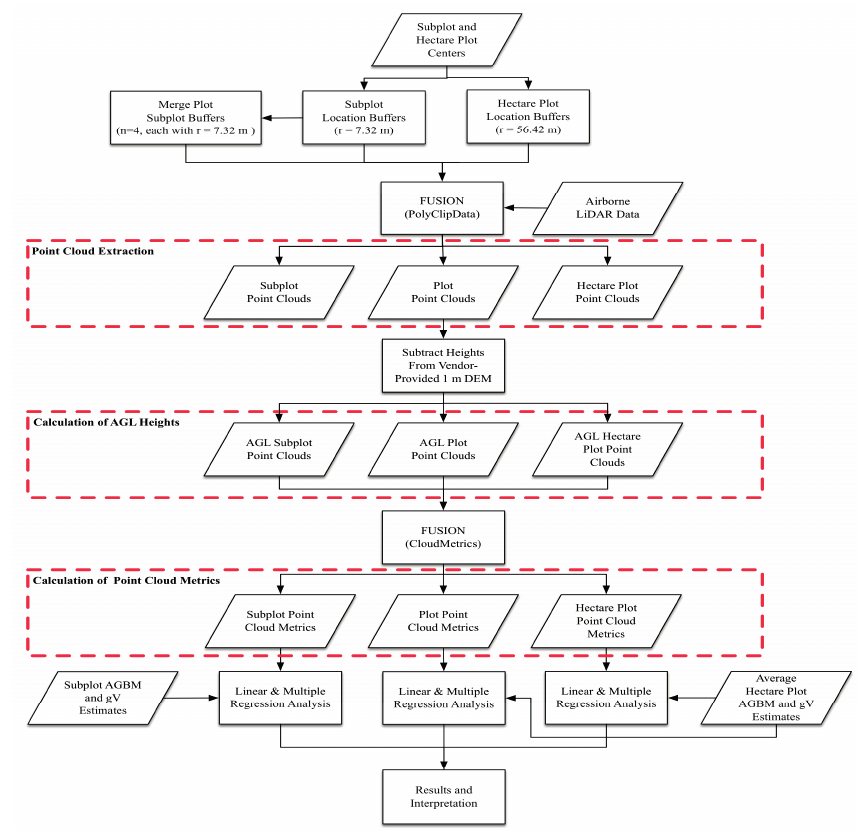
Figure 6. Flowchart of the light detection and ranging (LiDAR) data processing